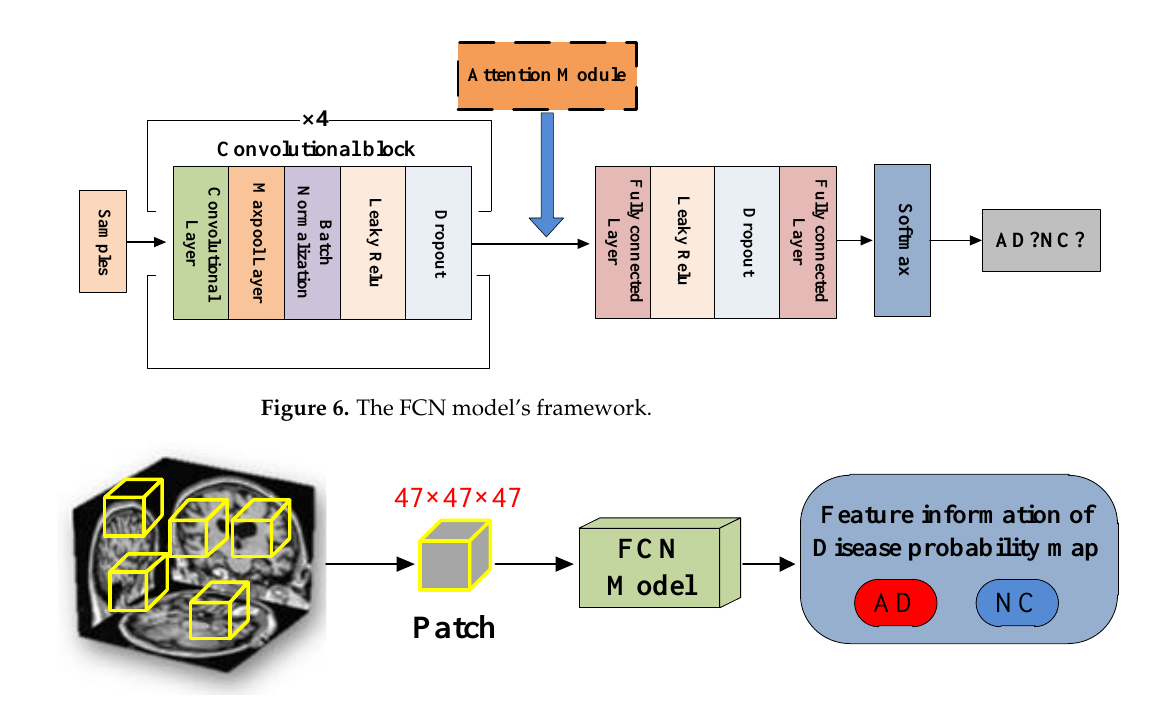
Figure 7. Randomly sampling 3D-MRI image’s patches for training the FCN Model.